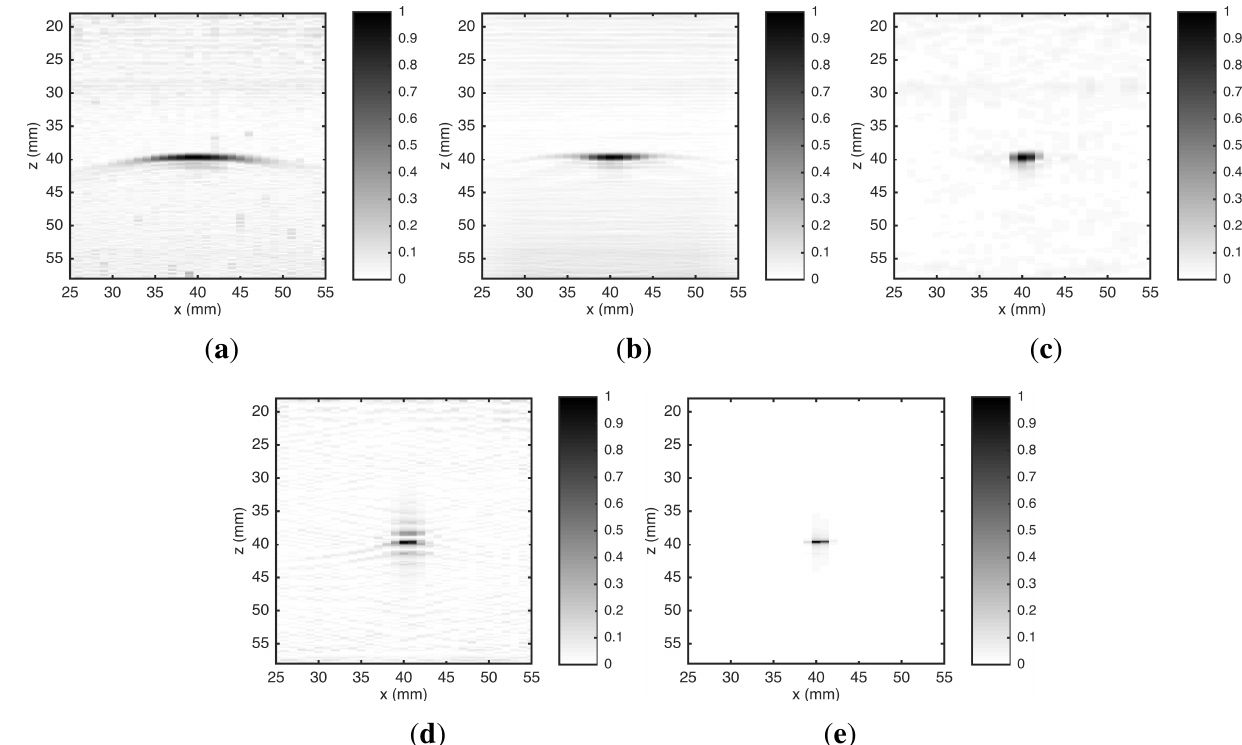
Figure 5. Reconstructed images of a SDH with 1 mm of diameter from real data acquired by UIS. The algorithms used in the reconstruction are: ( a ) B-scan ; ( b ) SAFT; ( c ) ω - k SAFT; ( d ) RLS and ( e ) UTSR. Amplitude scale was normalized to maximum absolute value.